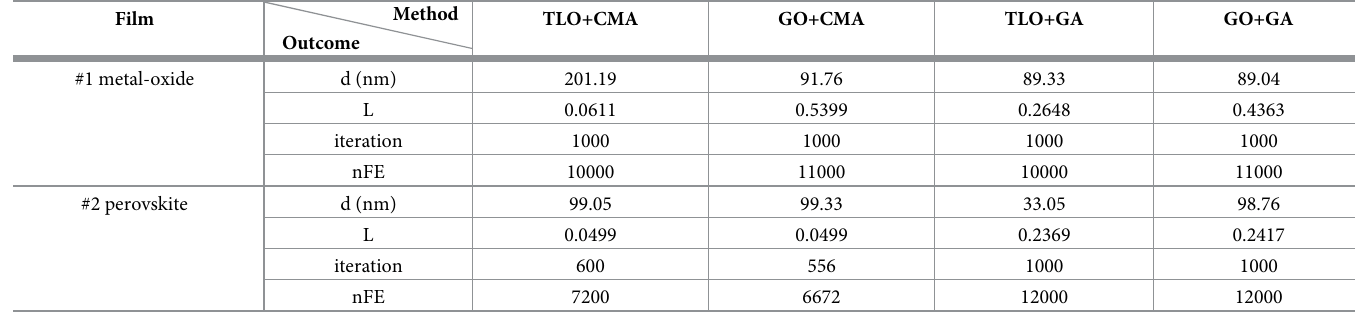
Table 5. Estimation performance of various methods on experimental data. In the present spectrophotometry, light beams fall straight (normally) on the films. Film